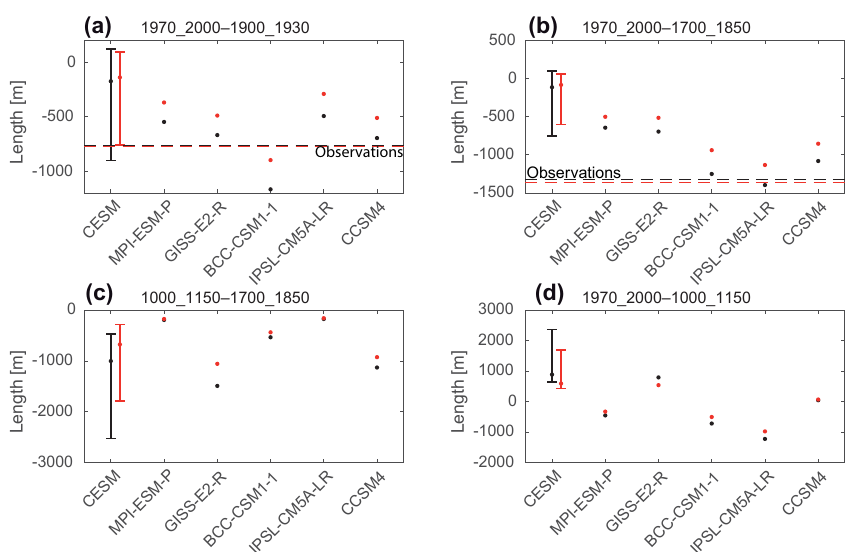
Figure 4. Mean (black) and median (red) of the difference in glacier length between (a) 1970–2000 and 1900–1930; (b) 1970–2000 and 1700–1850; (c) 1000–1150 and 1700–1850; and (d) 1970–2000 and 1000–1150. In panels (a) and (b) , observations are given as a horizontal dashed line. No observation is available for (c) and (d) . For (b) , the average of model results is made only for the glaciers that have observations. For CESM, the bar gives the ensemble range.